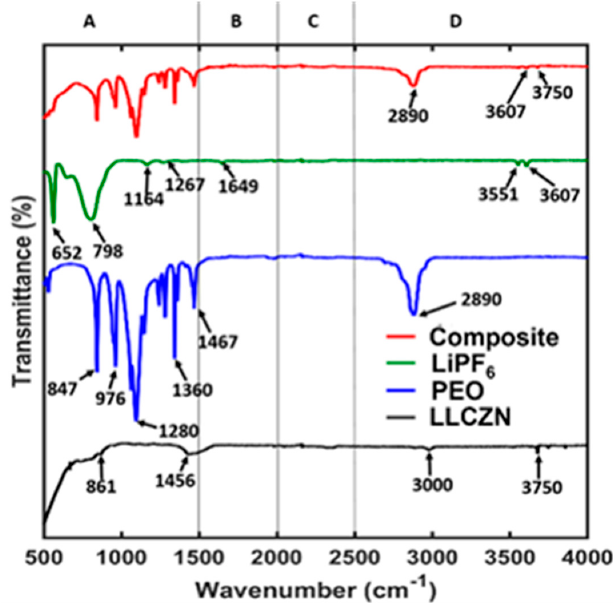
Figure 4. FTIR spectra of composite, LiPF 6, PEO, and LLCZN.